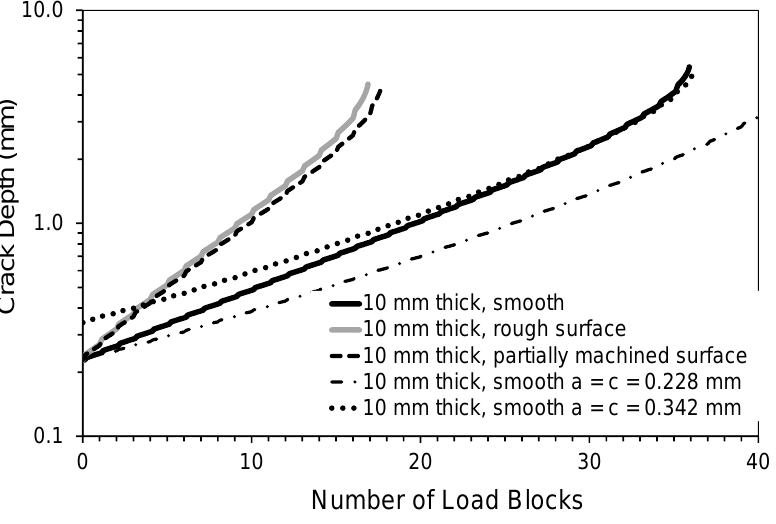
Figure 11. The computed crack depth curves for a 10 mm thick specimen.